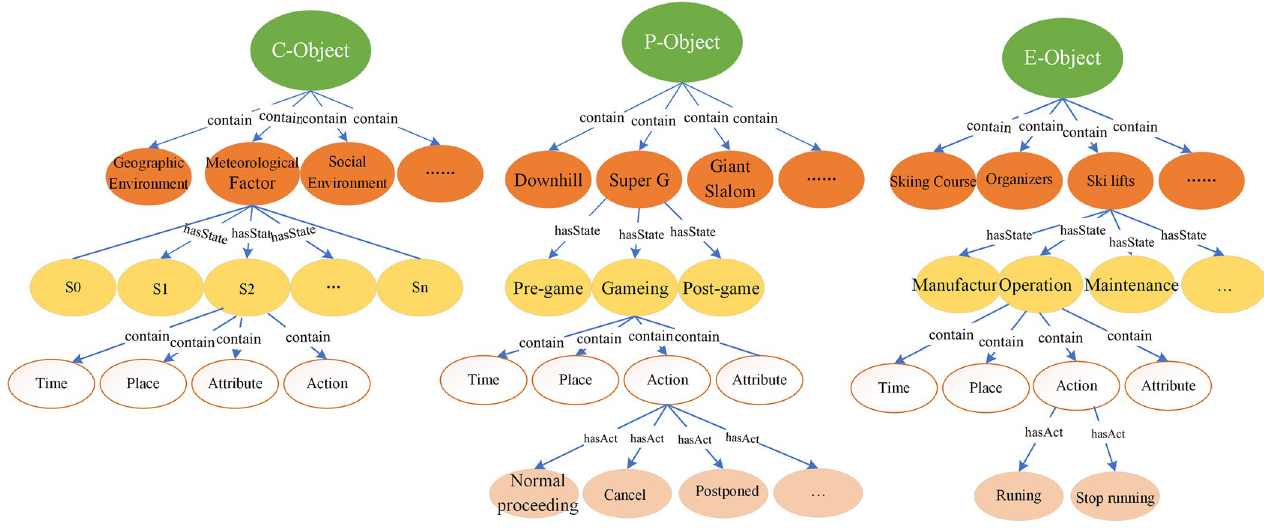
Fig 5. Schematic diagram of the KG of alpine skiing